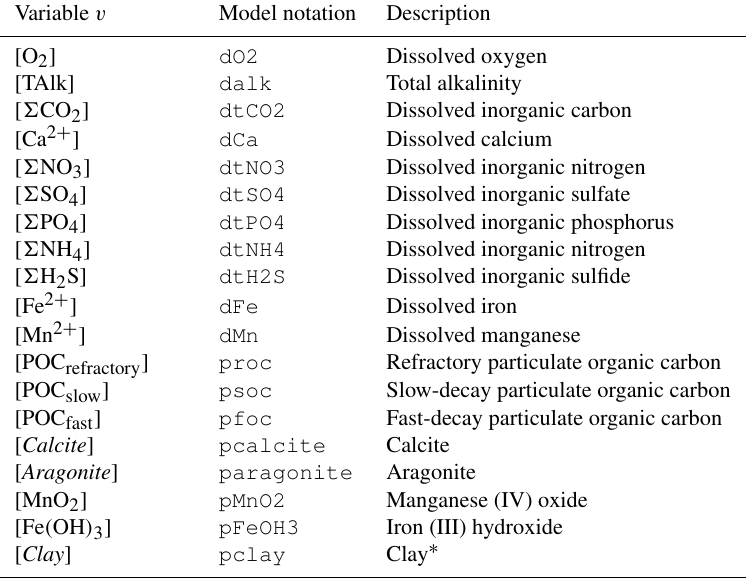
Table 2. Nomenclature of modeled chemical species. All variables are concentrations, expressed in mol per cubic meter of solid for solid species and mol per cubic meter of water for solute